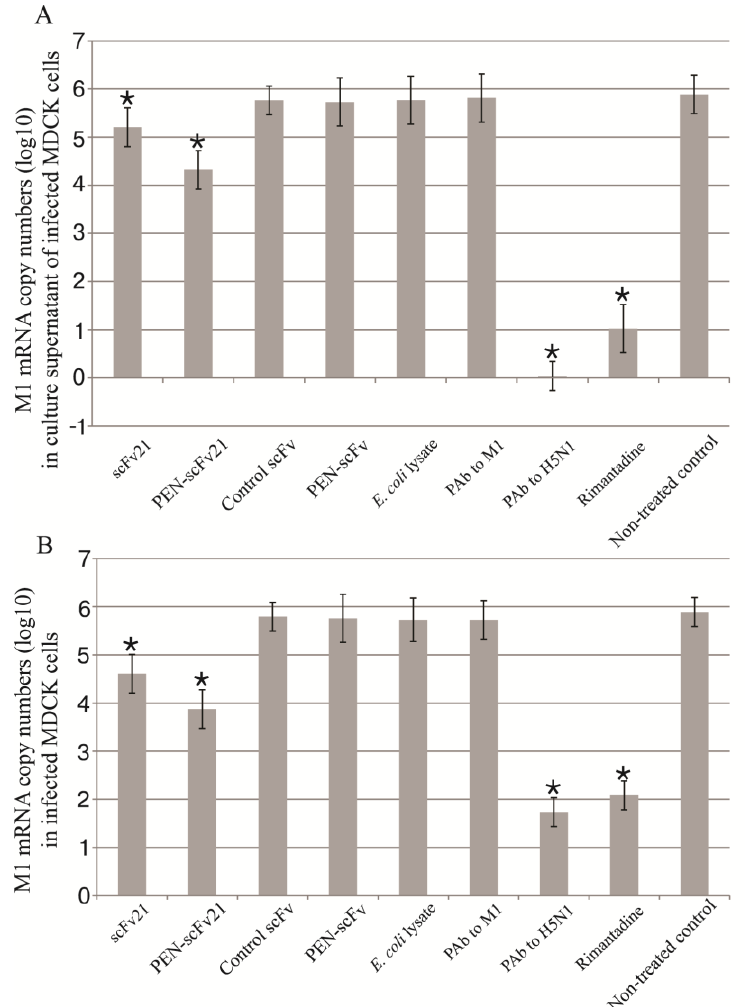
Figure 3. M1 mRNA copy numbers (log 10 ) in ( A ) culture supernatants and ( B ) inside the